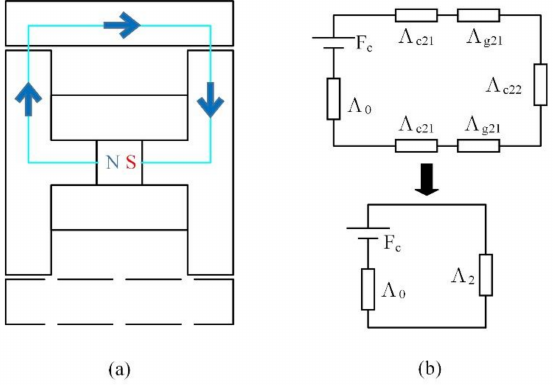
Figure 4. The axial cross section: ( a ) The magnetic circuit; ( b ) The equivalent magnetic circuit.